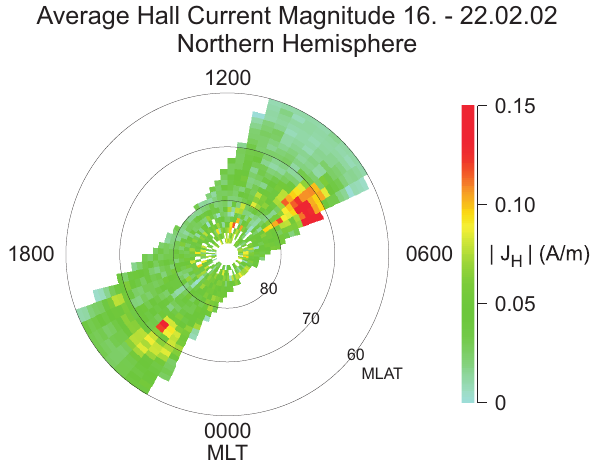
Fig. 10. Hall current magnitude averaged for all orbits of the seven days of our campaign in a magnetic latitude–magnetic local time